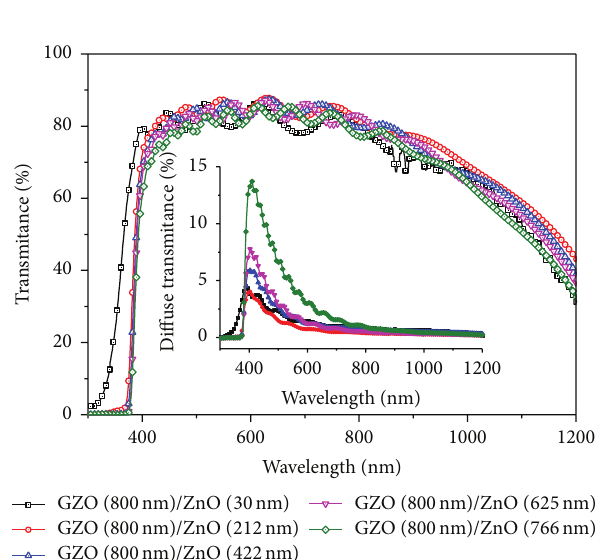
Figure 9: Optical properties of GZO film with thickness ∼ 800 nm on different ZnO buffer layer thicknesses. The deposition temperature of GZO film was 400 ∘